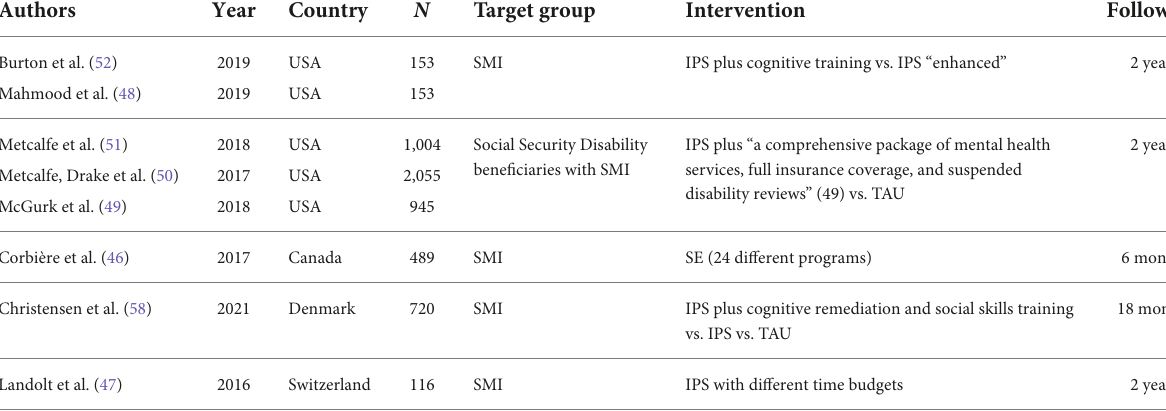
TABLE 1 Characteristics of included articles ( n =